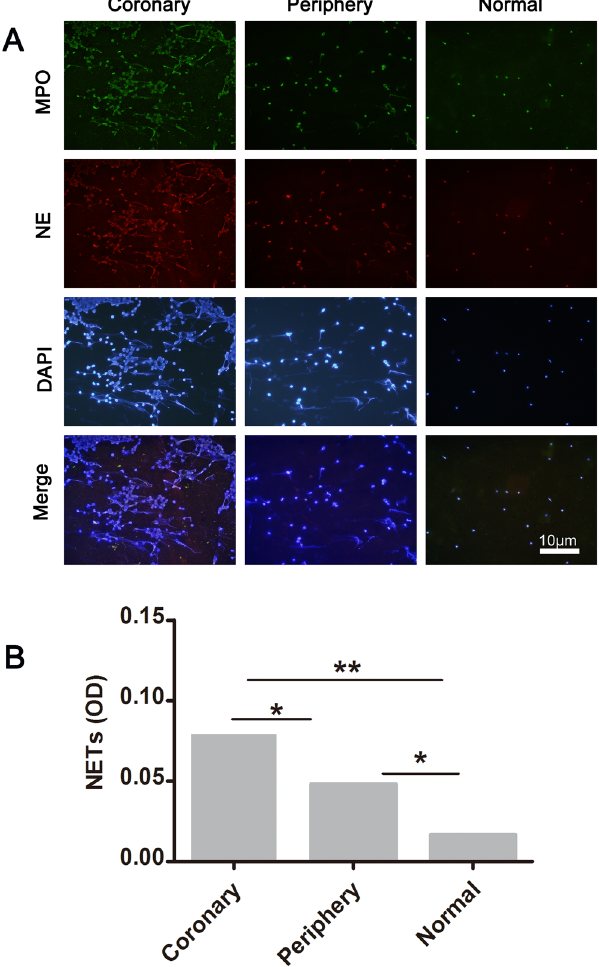
Figure 1. Neutrophils from infarct-related artery and peripheral artery blood of same patients with STEMI form NETs. ( A ) Immunostaining for NETs obtained from infarct-related artery, peripheral artery blood (n = 36), and rare phenomenon was observed in any healthy control individual(n = 5), and the proportion of neutrophils with NETs was significantly higher in STEMI than healthy individual. ( B ) Integrated optical density(OD) of NETs were measured using ImageJ software, and NETs OD per area in coronary artery was higher than radial artery and control individual. Accordingly, NETs OD per area in radial artery was higher than control individual. Green: MPO; red: NE; blue: nucleus labeled with DAPI. One representative out of 36A independent experiments is shown in A. Original magnification: A × 200, scale bar in A, 10 μ m, figures demonstrate as mean Optical Density (OD) for ( B ). ** P < 0.01, * P <